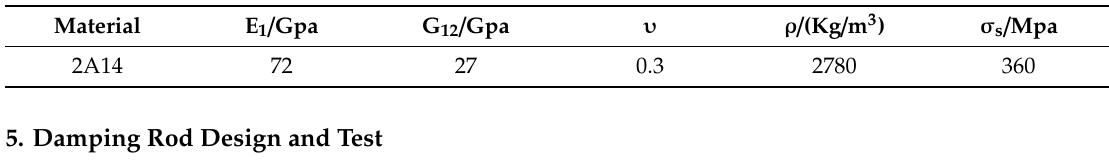
Table 4. Properties of aluminum